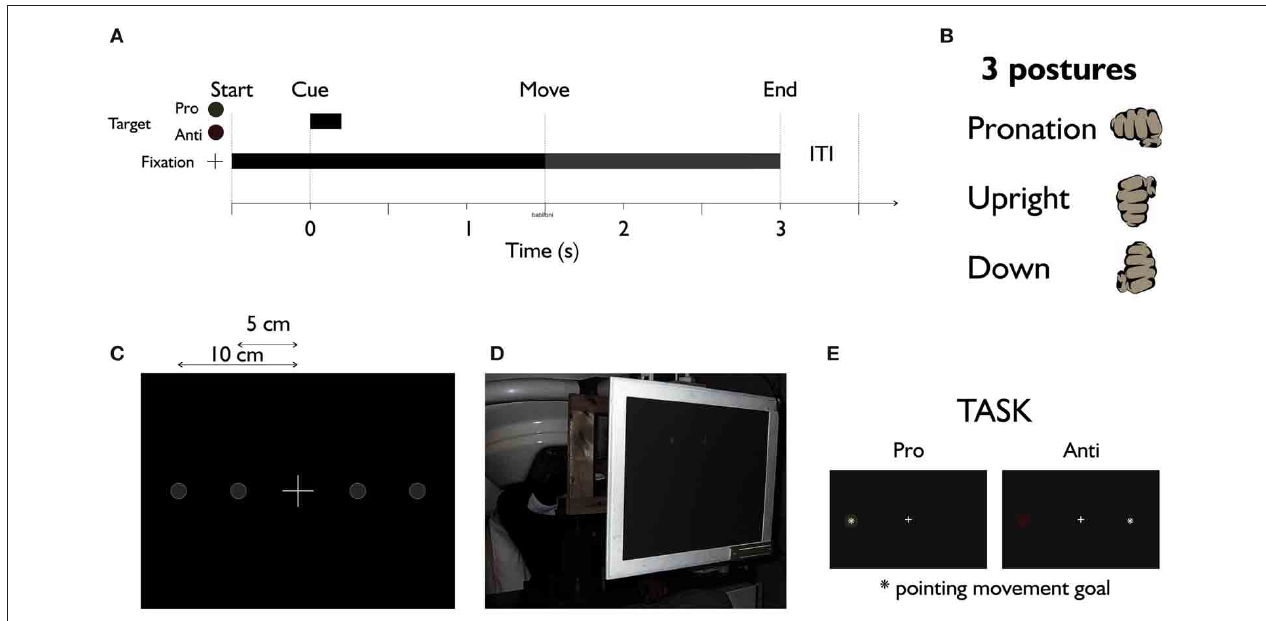
FIGURE 1 | The MEG experiment setup. (A) Time course of the experiment. (B) Three postures of the hand were used in different recording blocks. (C) The fixation cross in the middle with two possible target locations in its left and right hand side. (D) Subjects sit upright under MEG machine